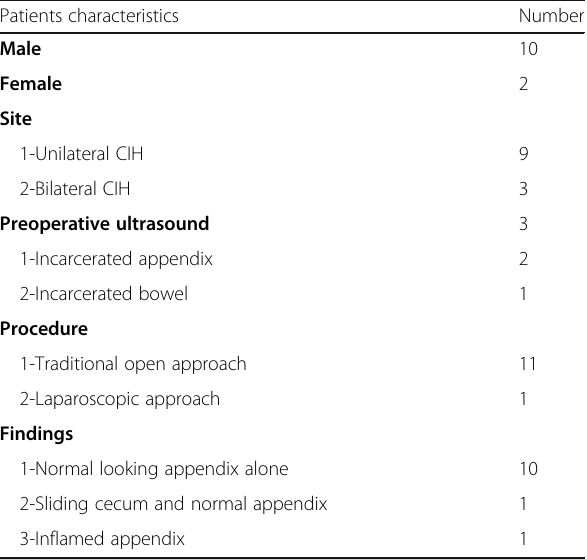
Table 1 Patients characteristics Patients characteristics